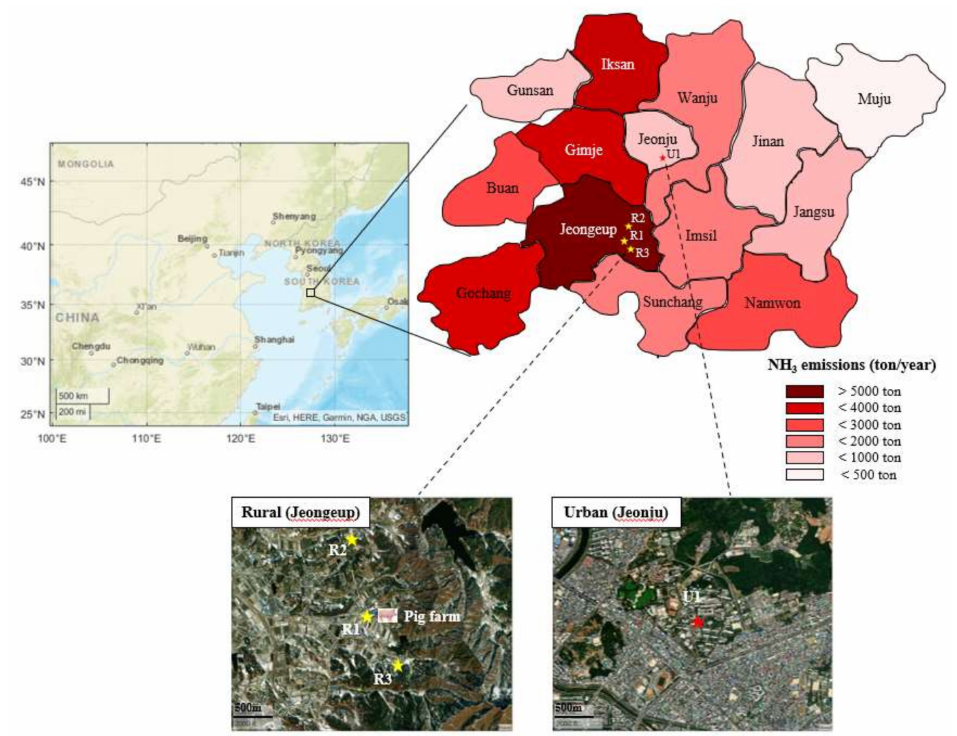
Figure 1. Location and map of the monitoring sites in the rural (Jeongeup) and urban (Jeonju) areas of Jeollabuk-do, South Korea. Colors on the map indicate the NH 3 emissions for 2017 based on the emissions inventory of South Korea in CAPSS 2017